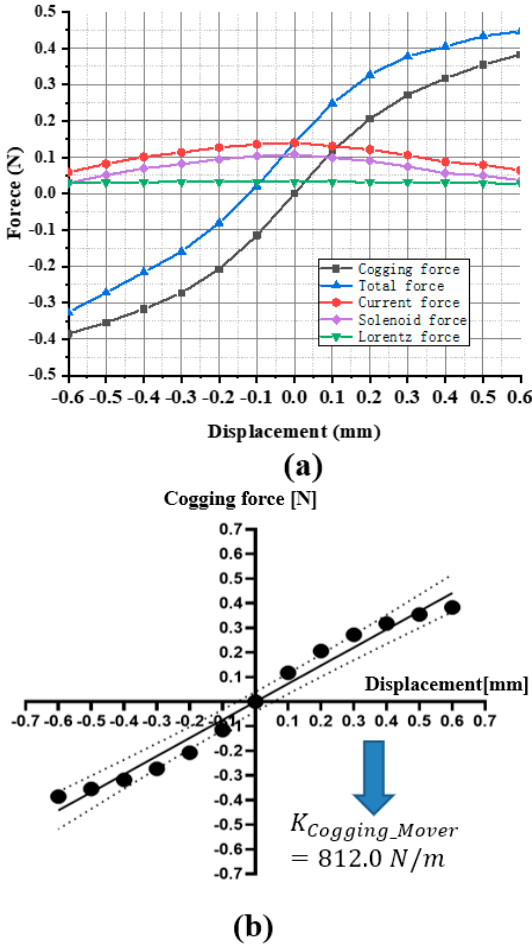
Actuators 2023 , 12 , x FOR PEER REVIEW Figure 8. Force profile: ( a ) different force distributions and ( b ) cogging stiffness of linear motor. According to the above analysis, the cogging force is affected by the magnetic interaction between the mover and stator. Full-magnet, X − magnet − only, and Y − magnet − only models were made to verify the cogging force effect on the total stiffness. The Y − magnet − only model included magnet #Y1, magnet #Y2, and two yokes. The sample preparation, models, and samples are shown in Figure 9.